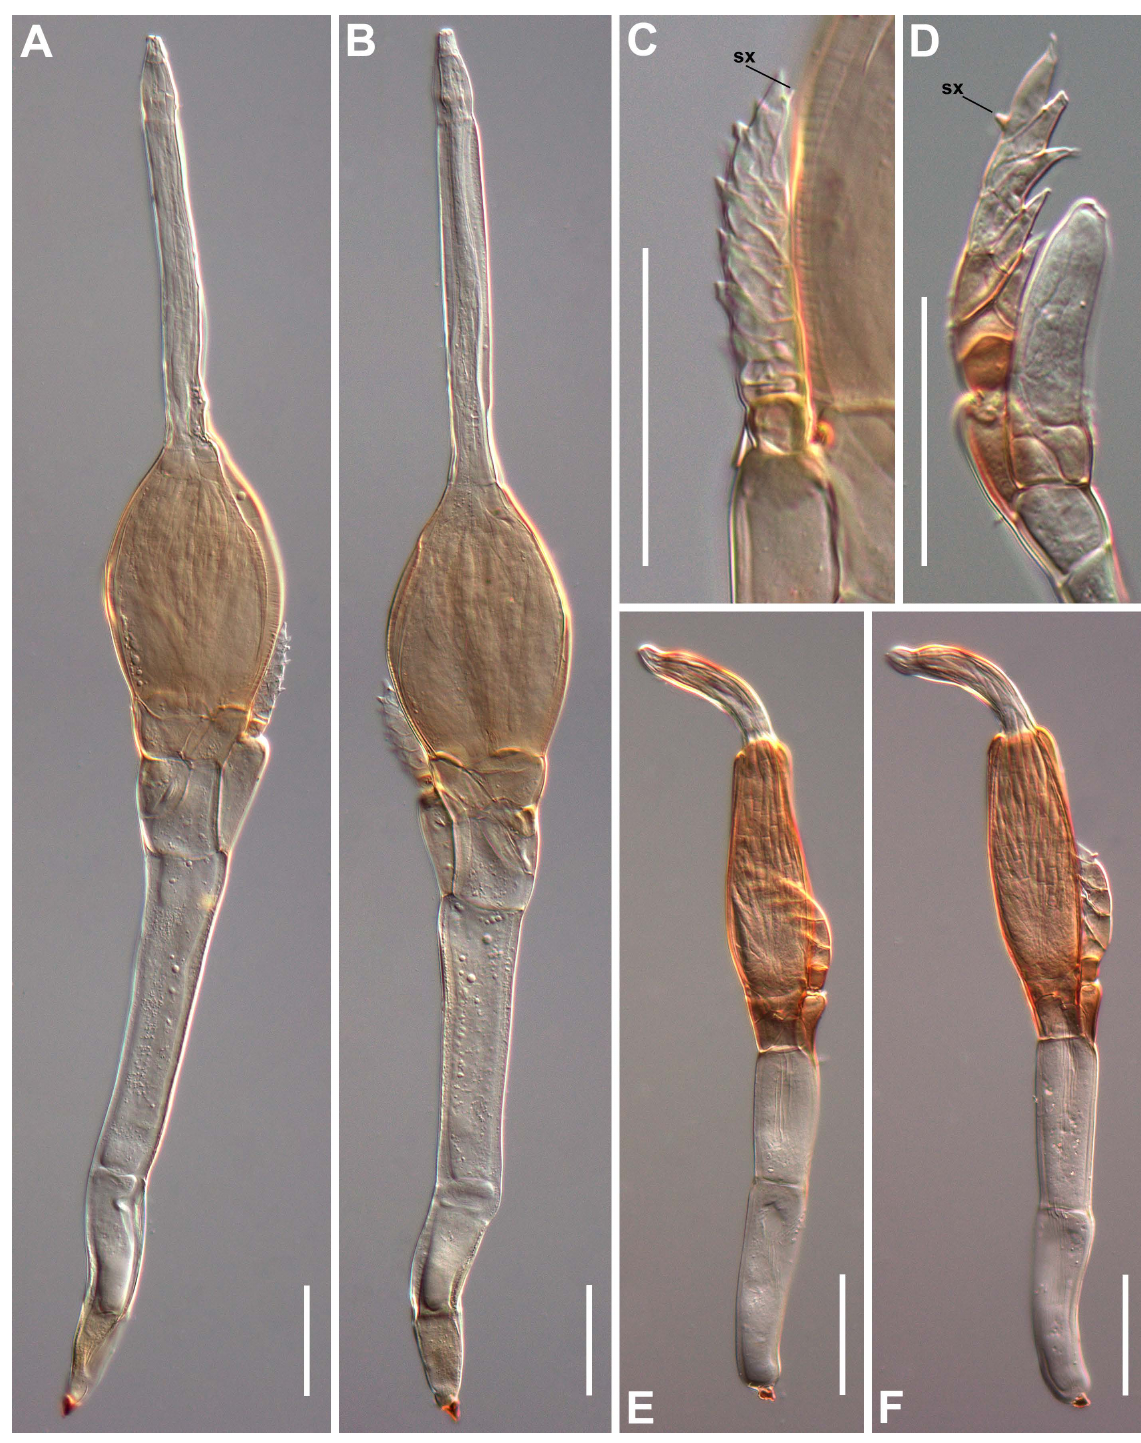
Fig. 58. Stigmatomyces spp. A – C . S. entomophilus (Peck) Thaxt. A – B . Mature thalli. C . Primary appendage in detail showing spinous process from the original spore apex (sx). – D – F . S. ephydrae L.Mercier & R.Poiss. D . Primary appendage in detail showing spinous process from the original spore apex (sx). E – F . Mature thalli. Scale bars: 50 µm. Photographs from slides ZMUC C-F-124020 (A–C), ZMUC C-F-124262